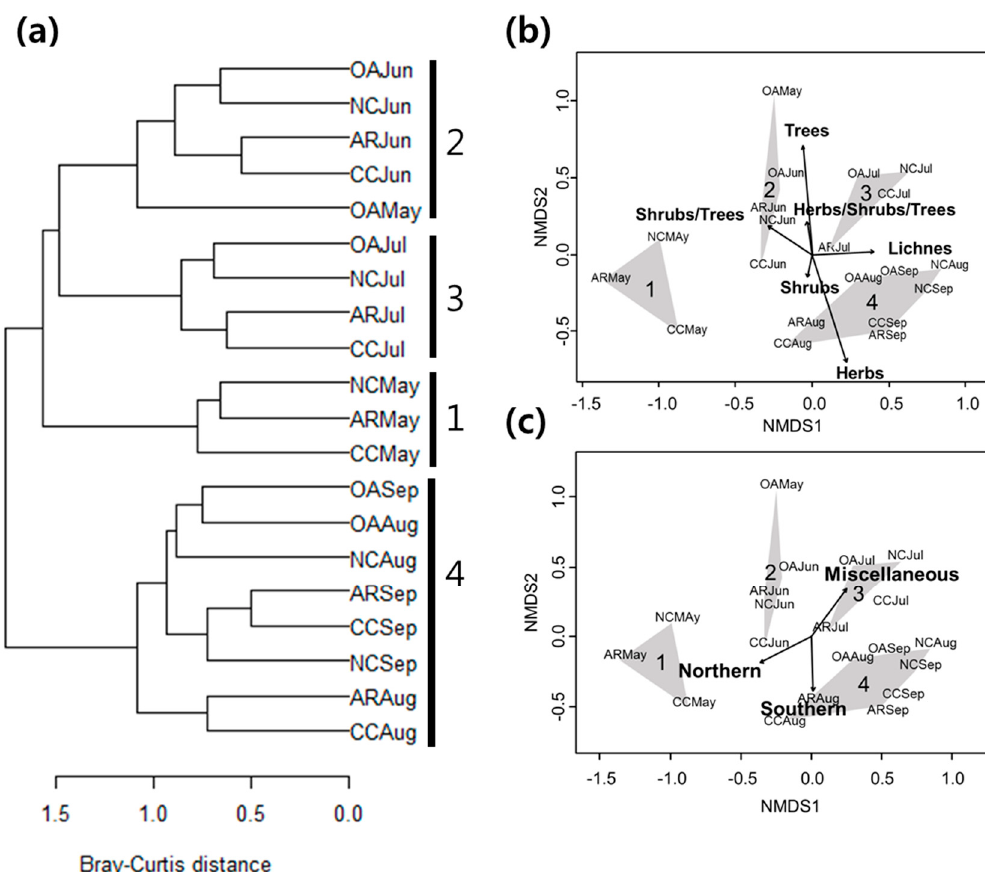
Figure 7. ( a ) Cluster analysis of species abundance of moths in the monthly samples using Bray-Curtis distance and Ward’s linkage method. ( b and c ) Ordination of NMDS using the same data used in the cluster analysis (stress value for the first two axes = 0.15). The abundance proportion of each functional group for host plants ( b ) and distribution patterns ( c ) is presented in the NMDS. The first two characters in sample names indicate study stands, and the last three characters are sampling months.